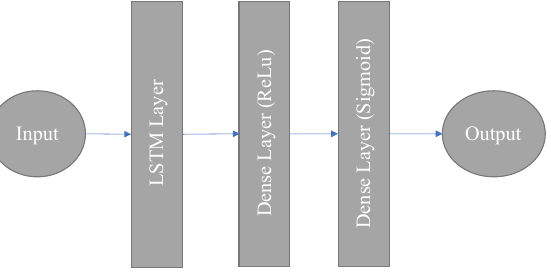
Figure 5. Deployed LSTM neural network for proximity